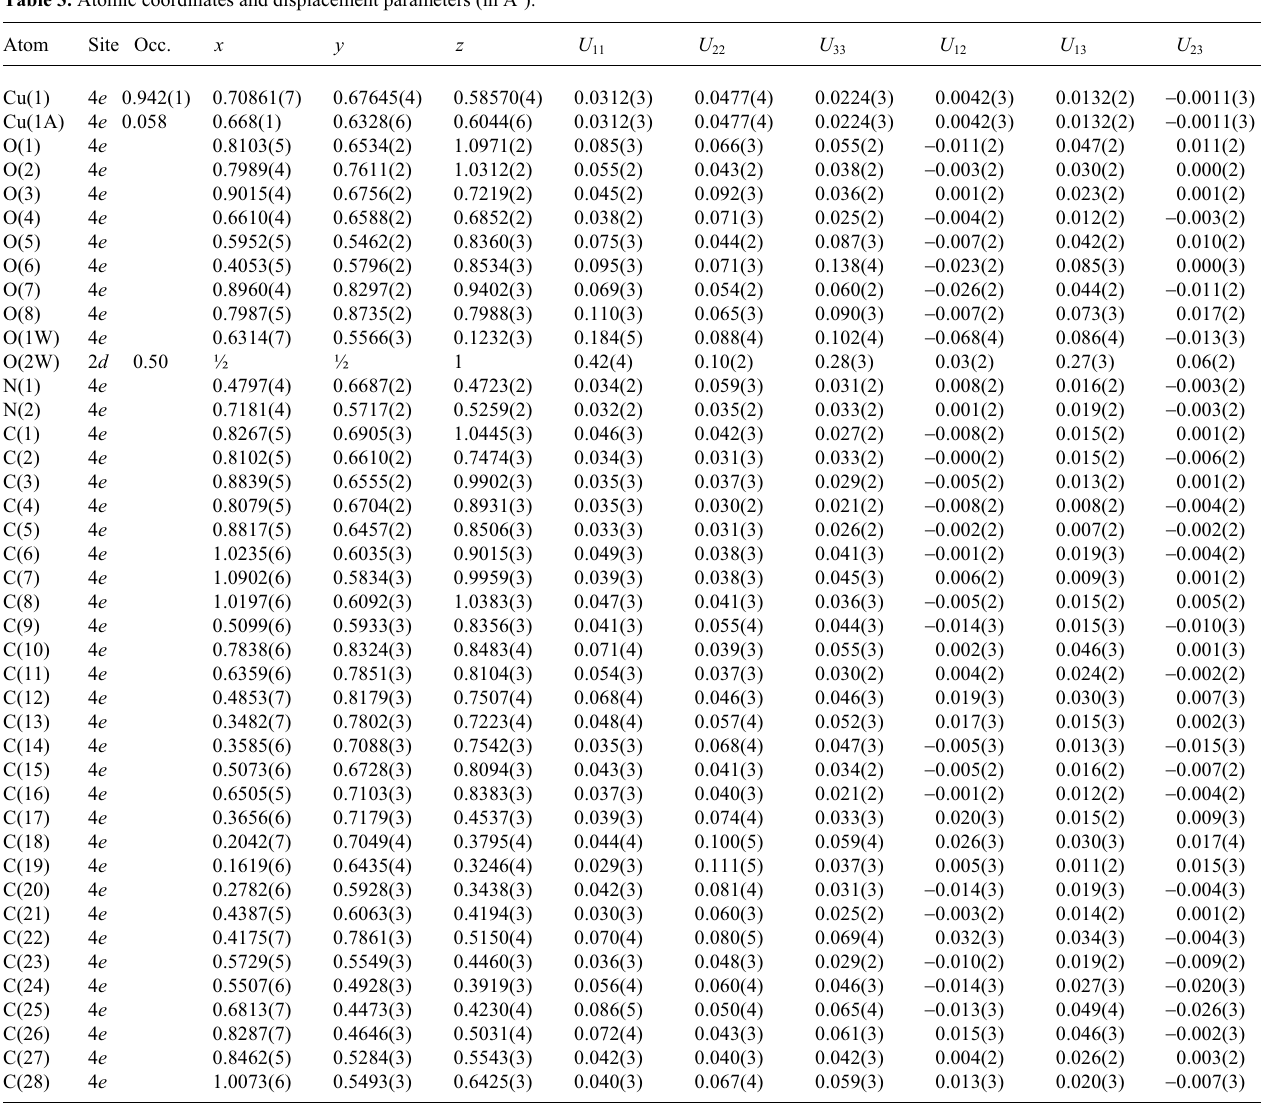
Table 3. Atomic coordinates and displacement parameters (in Å 2 ).